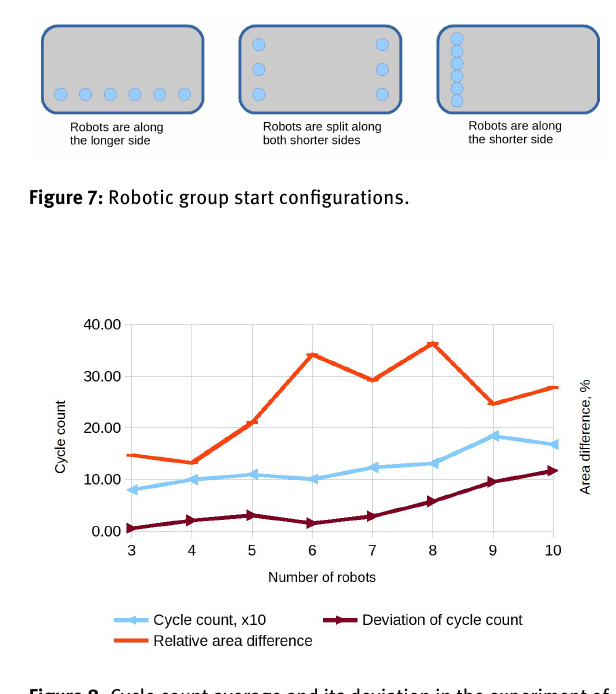
Figure 8: Cycle count average and its deviation in the experiment of numbers of robots variation.